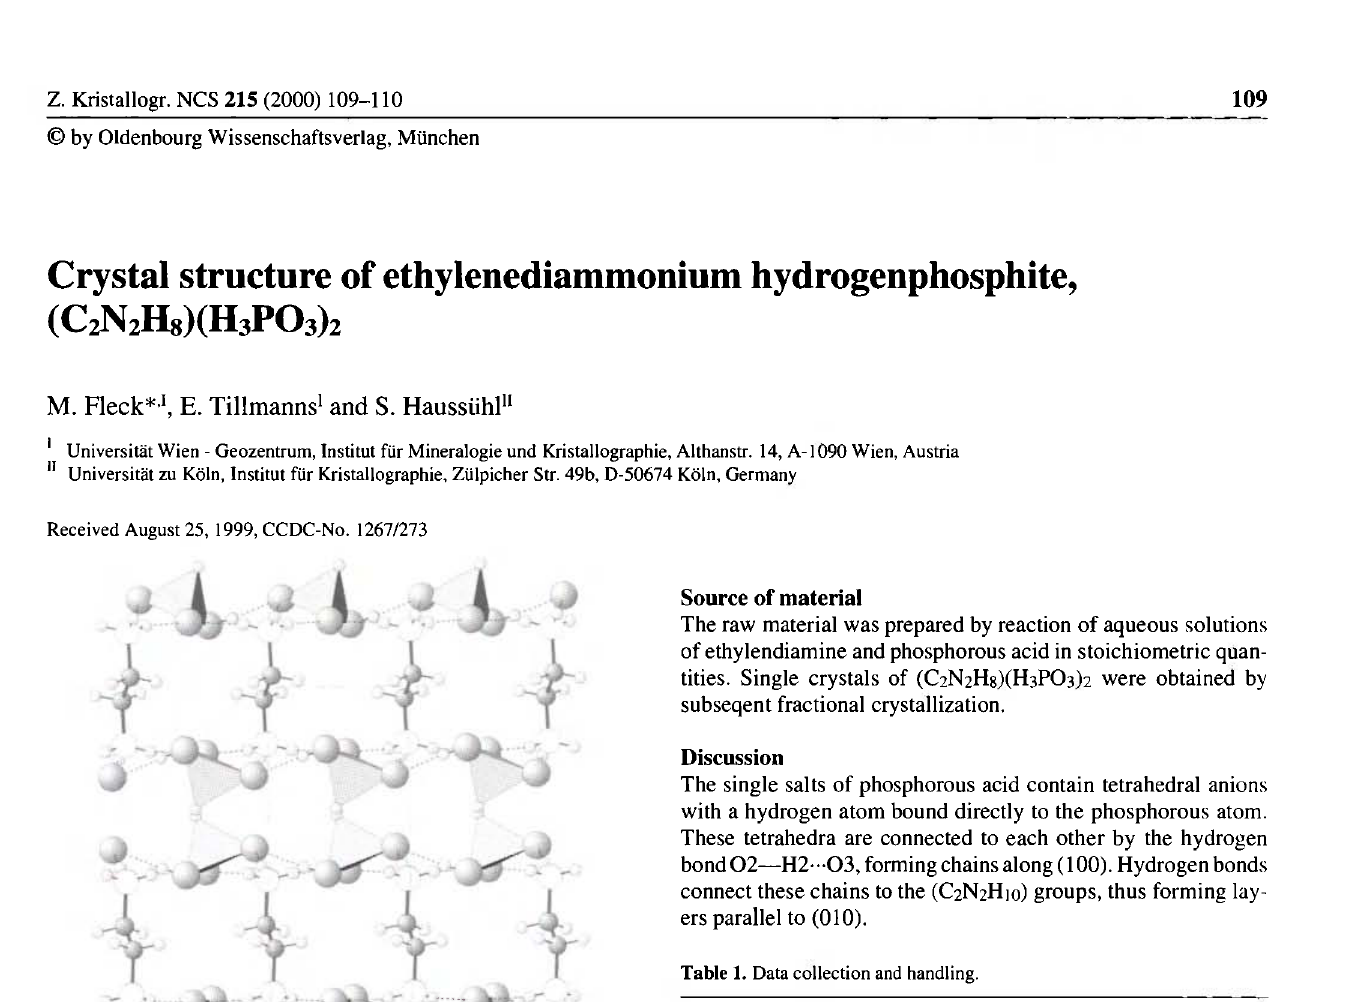
Table 2. Atomic coordinates and displacement parameters (in Ä